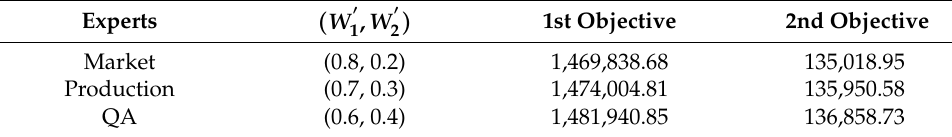
Table 5. Decision-making matrix in Shannon entropy.